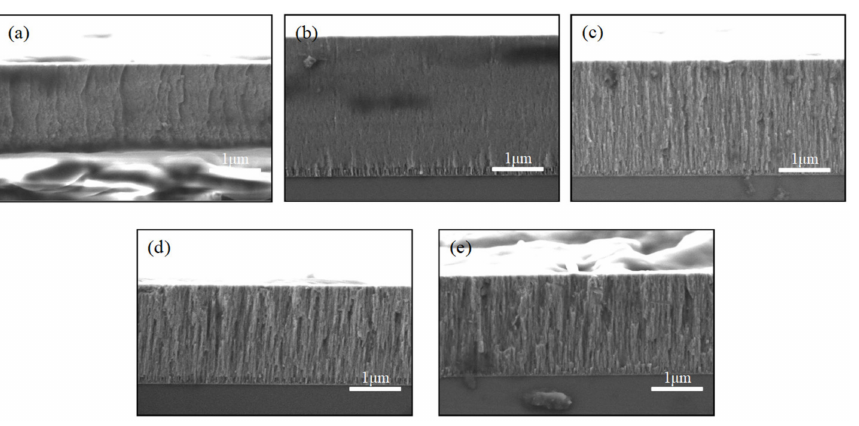
Figure 3. Cross section FESEM micrographs of the composite coatings ( a ) 0.6 Pa, ( b ) 0.9 Pa, ( c ) 1.2 Pa, ( d ) 1.5 Pa, ( e ) 1.8